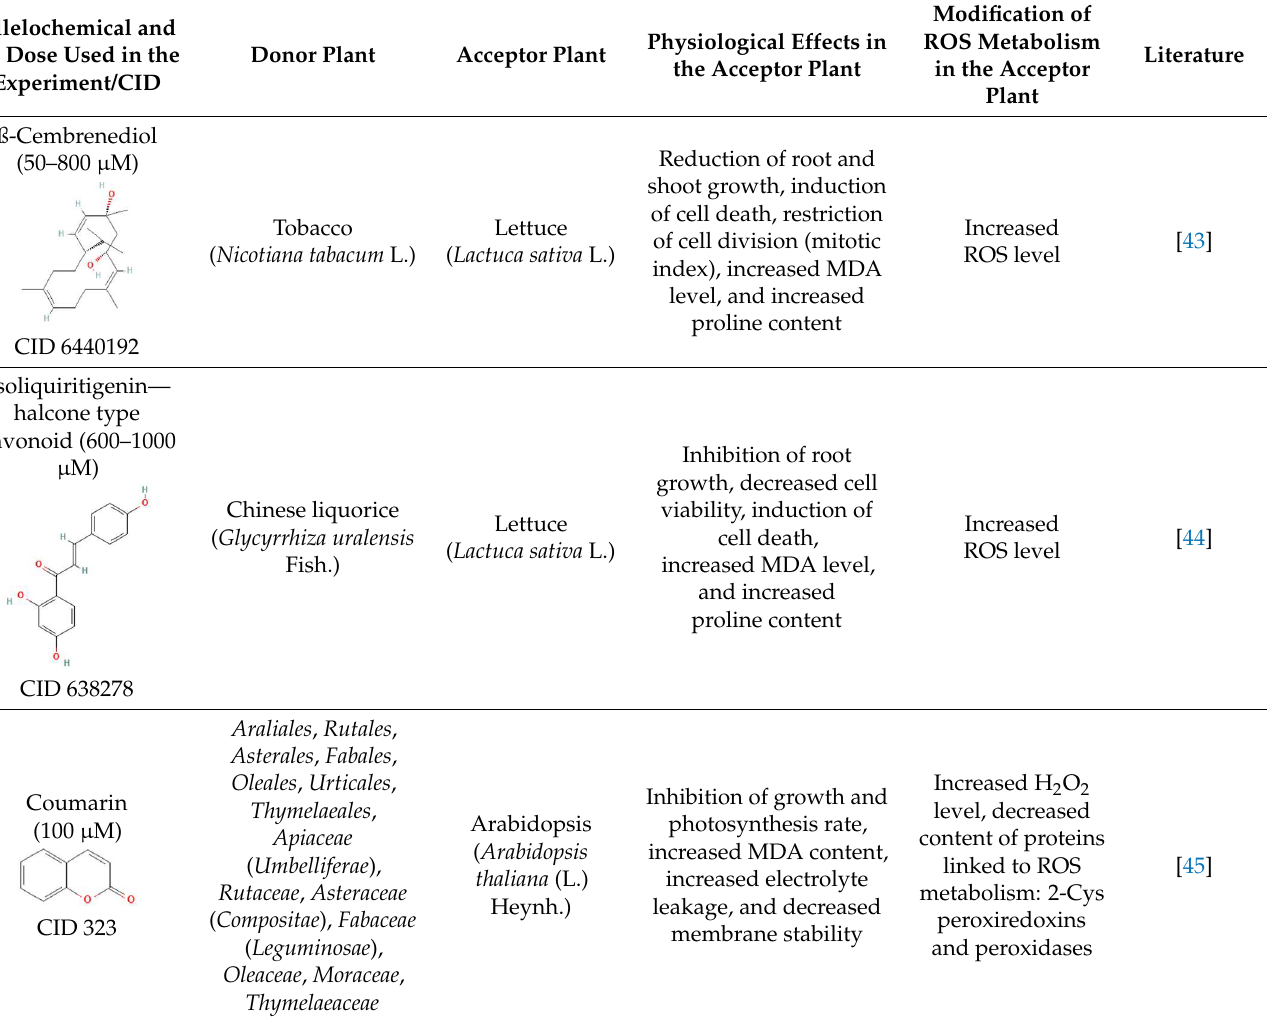
Table 1. The modification of ROS metabolism as an element of allelopathic activity of individual chemicals. The physiological effects of the phytotoxin in the acceptor plant were correlated to oxidative damages or ROS mediated/dependent processes. Structures of allelochemicals were downloaded from PubChem database (CID no), references for PubChem data are included in Supplementary Materials.